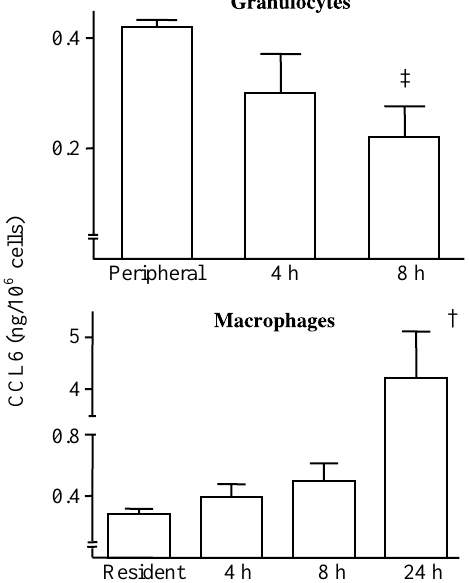
FIG. 5. Intracellular level of CCL6. Granulocytes and macro- phages were isolated from peripheral blood or from the peritoneum after thioglycollate injection as indicated. CCL6 levels in cell extracts were measured with ELISA (three to five groups at each time-point). % p B / 0.05, $ p B / 0.001, when compared with peripheral granulocytes or resident macro-